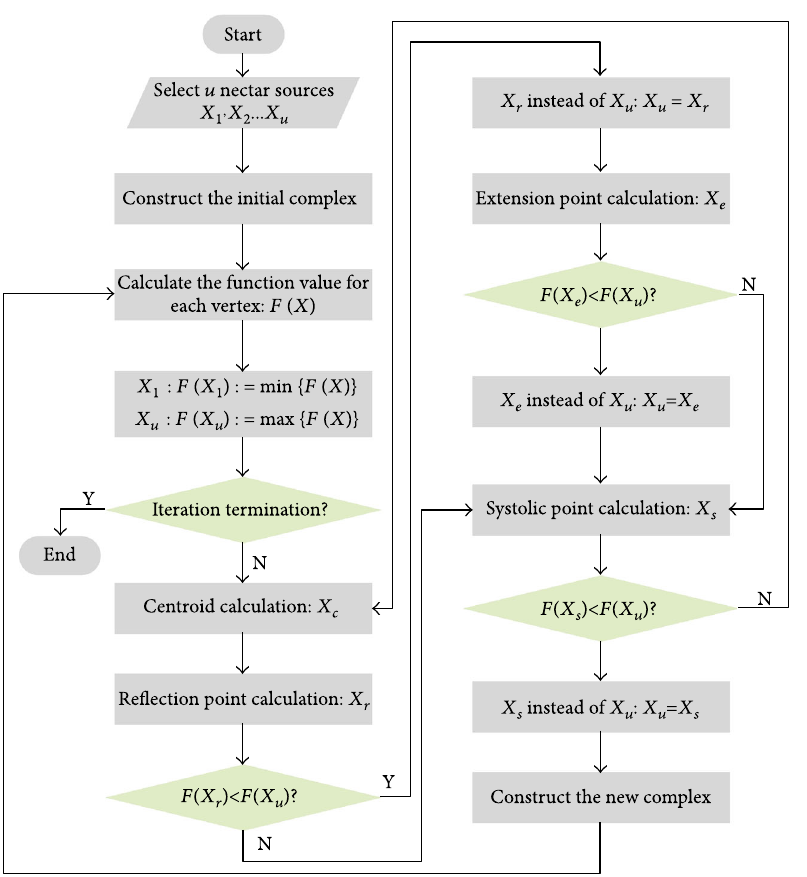
Figure 6: Flow diagram of the complex optimization